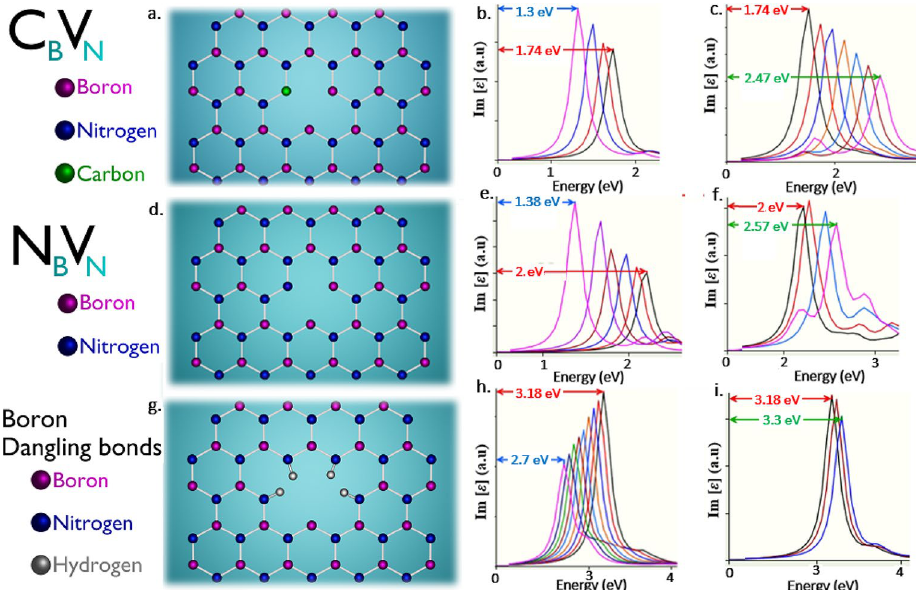
Figure 11. Schematic illustration of DFT computed C B V N , N B V N , boron dangling bonds and their corresponding tunable quantum emission towards lower and higher energy regions. ( a , d , g ) Schematic illustration of C B V N (nitrogen mono vacancy with carbon interstitial), N B V N (nitrogen mono vacancy with self-interstitial) and boron dangling bonds defects whose ZPL energies are observed at 1.74 eV, 2 eV and 3.18 eV respectively and corresponding tunable quantum emission towards lower and higher energy region for applied one-sided lateral, longitudinal and biaxial strains as described in Tables 3 and 4. ( b , e , h ) Tunability of defects towards lower energy region. ( c , f , i ) Tunability of defects towards higher energy region. All red colour arrows indicate ZPL energy under no strain. All blue colour and green colour arrows indicate tuned ZPL energies towards lower energy regions and higher energy regions respectively. The corresponding PDOS information of unstrained and strained quantum emitters were provided in Figure S3 (supporting